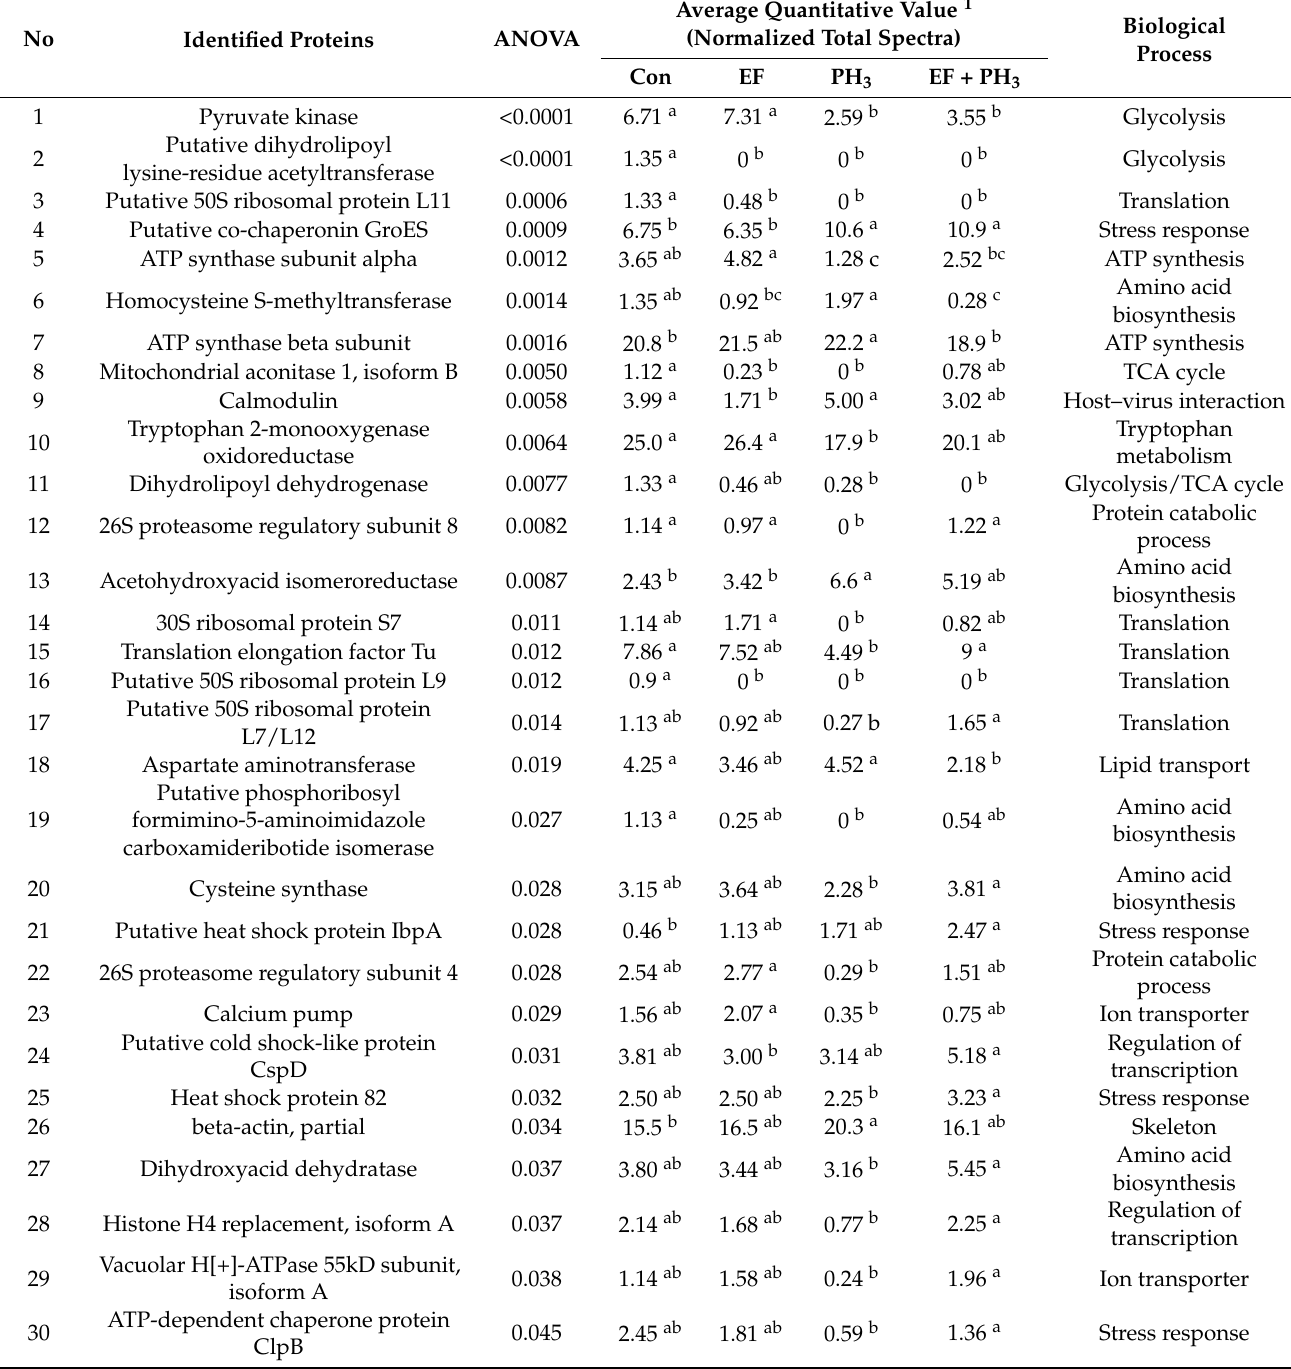
reduced in EF+PH3-treated samples compared to the control. The highest reduction was a 100-fold decrease in the phospholipid PI (O-16:0). Table 3. Significant protein expressions after exposure to different combinations of ethyl formate (EF) and phosphine (PH 3 ) on P. citri adults for 4 h at 20 ◦ C ( n = 20,